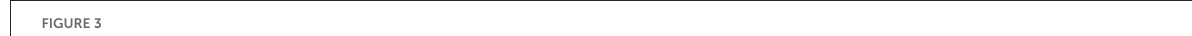
FIGURE3 from the box-indicated regions in (A–E) show the details. (B–E) At 6h, 1, 7, and 14 days after the operation, the microspheres were embedded in the phalloidin-labeled arteries, following with the downstream arteries denatured or even necrotic, and CD31-labeled capillaries surrounding the infarcted vessels were significantly expressed. (F,G) The three-dimensional images showed that the microspheres lodged in the blood vessels, causing downstream vascular necrosis and peripheral capillary proliferation. (H) The area ratio of CD31 significantly increased at all time points after the operation. The vascular alteration in all model rats presented in a similar pattern ( n = 7). The green dots in (B–F) were lodged in fluorescent microspheres. Scale bars: 200 µ m in (A–E) , 50 µ m in (A1–E3) , and 40 µ m in (F,G) . * p < 0.05 vs. normal group.